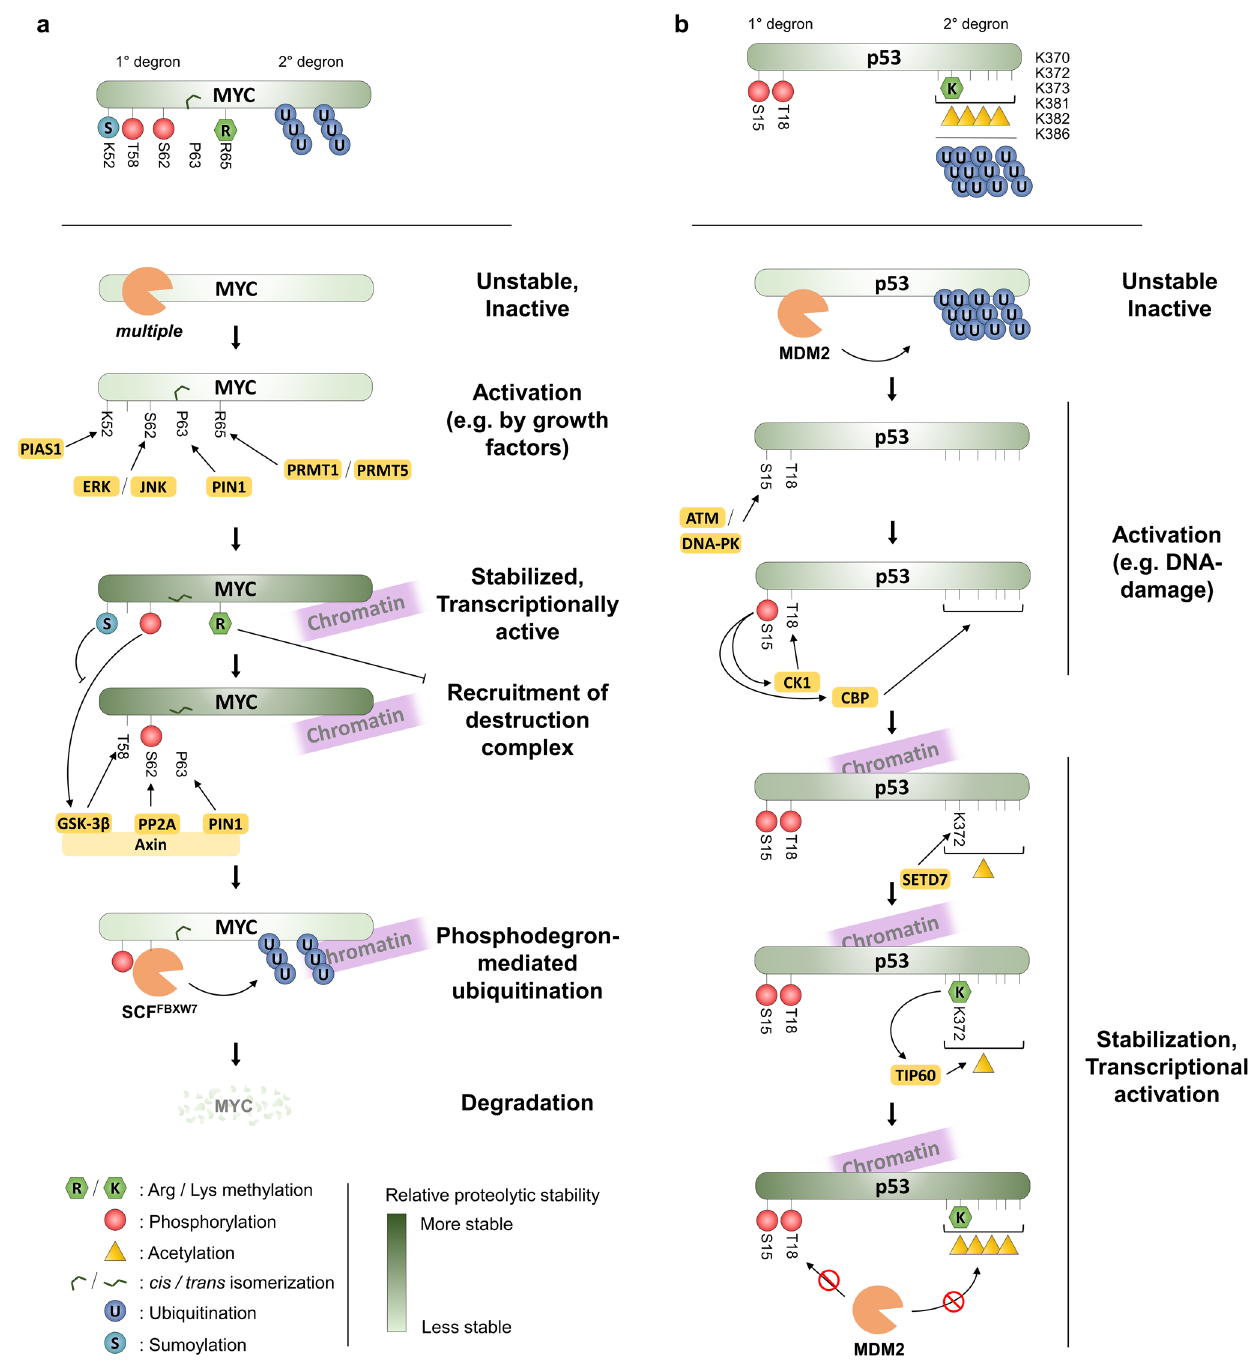
Fig.5|PTMcross-talkatdegrons.a ExamplesoftheregulationofMYCstabilityby different PTMs. In many cases, PTM networks are formed as one PTM acts as a priming factor for the next, by establishing protein-protein-interaction